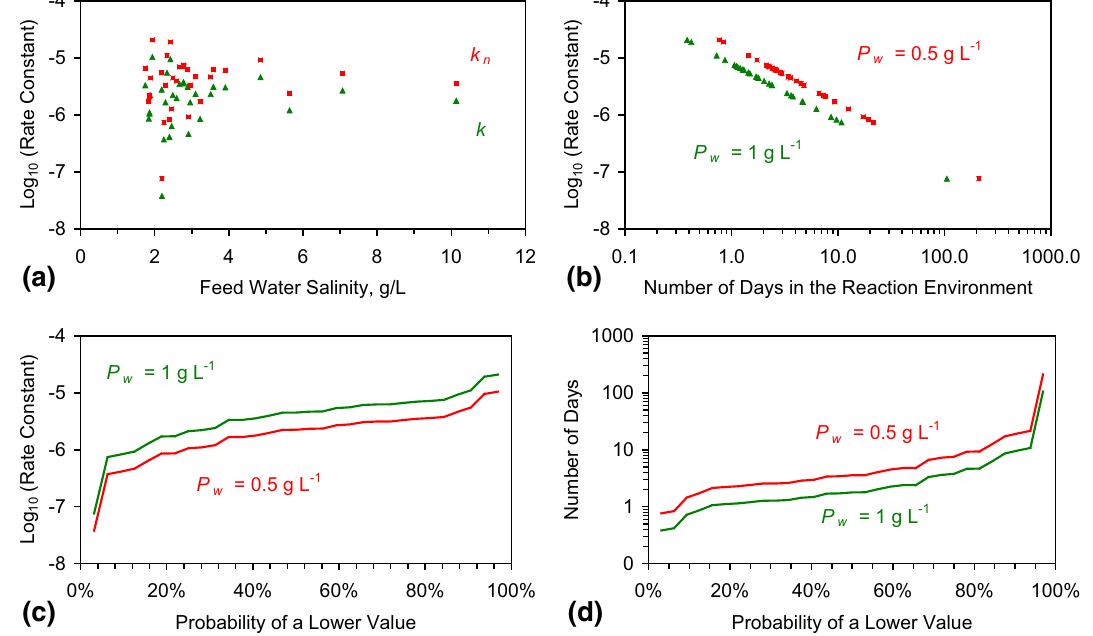
Fig. 8 Catalyst B: rate constants. a k and k n versus feed water salin- ity. b k n versus time required to reduce the water salinity by 50%. c k versus probability of a lower value. d Probability versus resi- dence time required to achieve a 50% reduction in salinity. The pri- mary control on k n is the O 2 saturation of the water. Trial